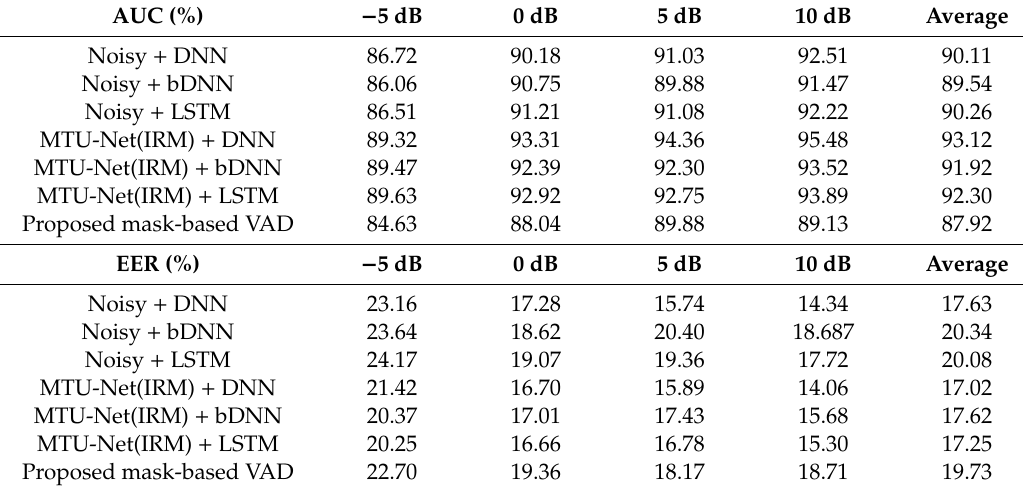
Table 4. Comparison of the receiver operating characteristic curves (AUCs) (%) and equal error rates (EERs) (%) of seven di ff erent voice activity detection methods according to their di ff erent signal-to-noise ratios under matched noise